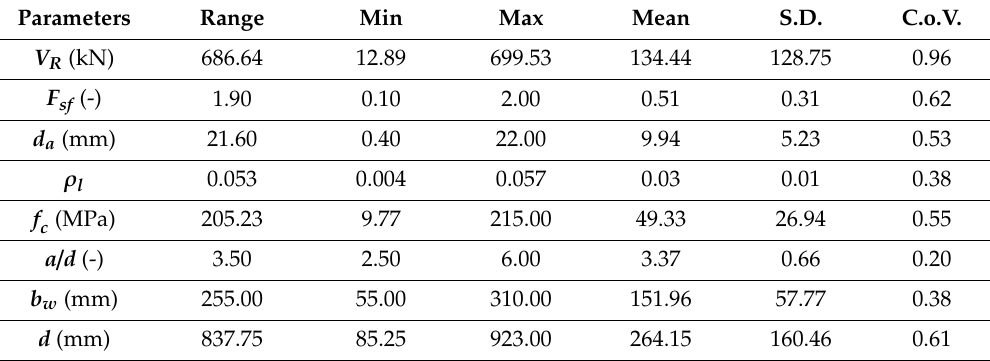
Table 2. Statistical summary of the experimental evaluation database